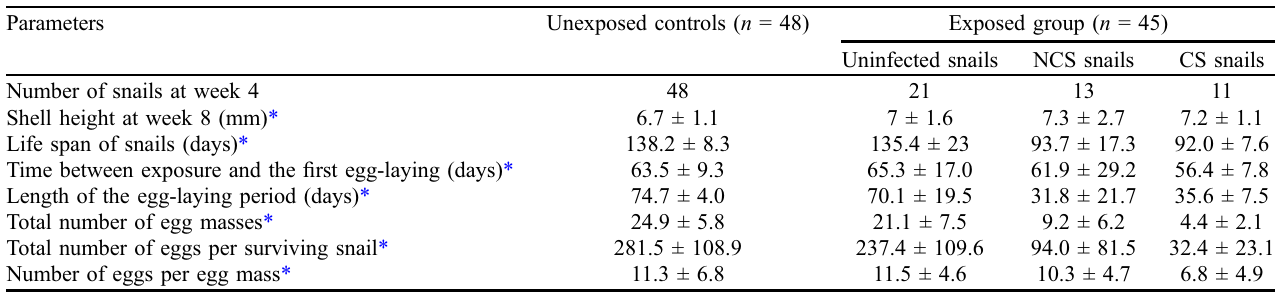
Table 1. Egg-laying of Radix natalensis (Egypt) subjected to two successive exposures (2 miracidia per snail in each case) with Fasciola hepatica (France). Each group consisted of 50 snails at the onset of the experiment. CS snails, cercarial-shedding snails; n , total number of surviving snails at week 4; NCS snails, snails containing free cercariae but without